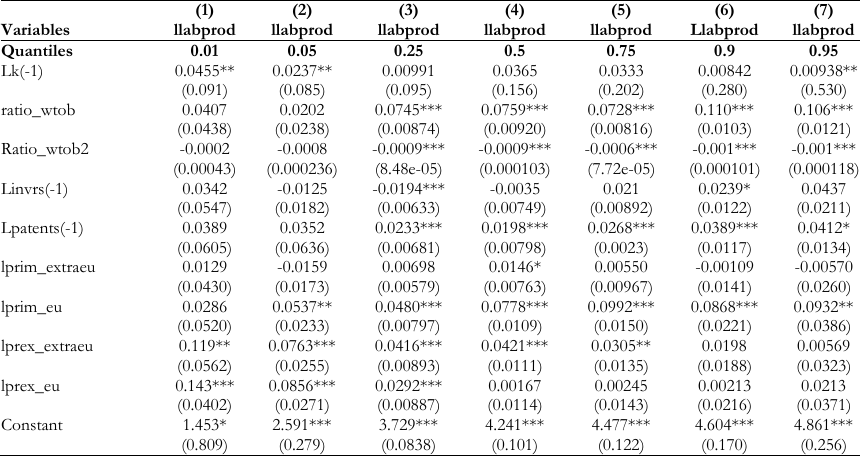
Quantile Regression Results for